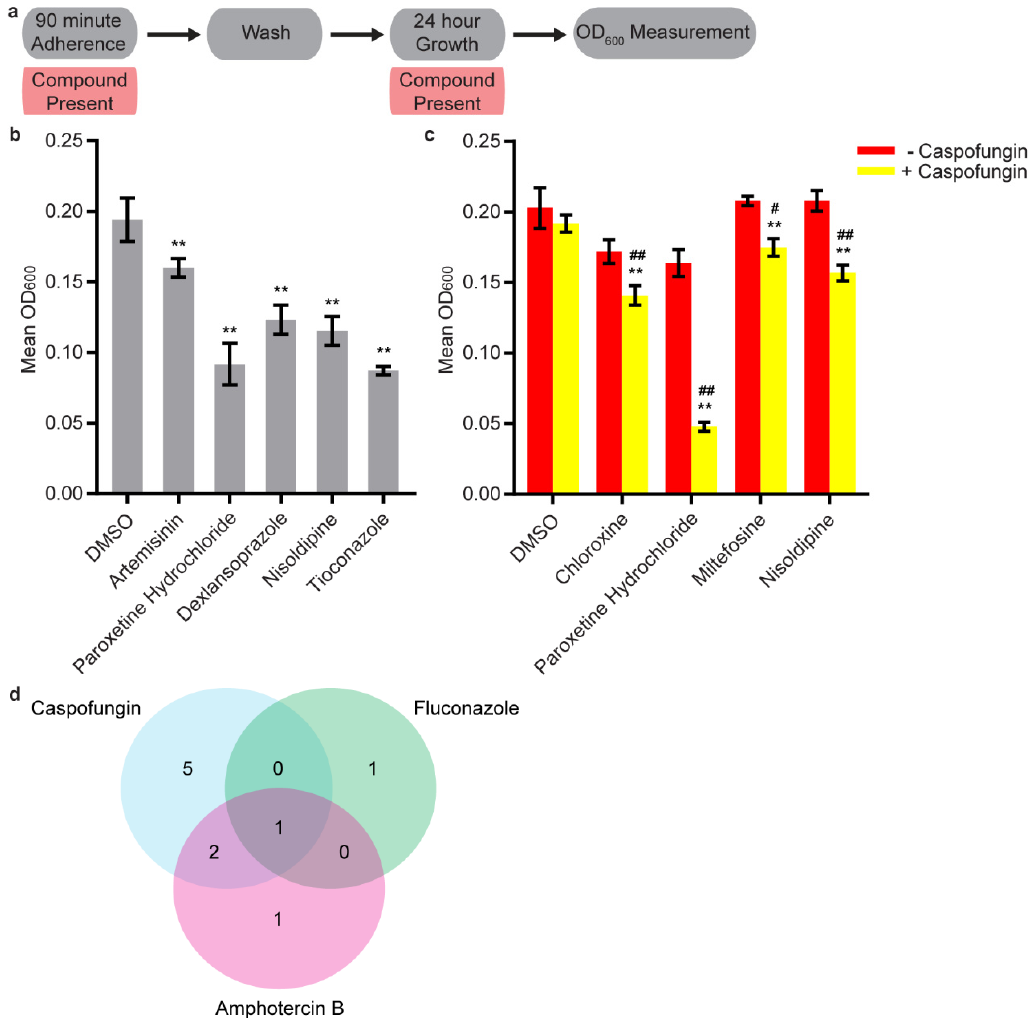
Figure 2. Thirteen candidate compounds inhibited biofilm formation by themselves or in combination with one or more known antifungal agents. ( a ) Overview of the experimental setup for the sustained inhibition optical density biofilm assay used for these experiments. Compounds were included during both the 90-min adherence step and the 24-h growth step of in vitro biofilm formation. ( b ) Subset of the statistically significant hits from the stand-alone sustained inhibition optical density biofilm assay. Mean OD 600 readings with standard deviations are shown, significant di ff erences from the DMSO solvent control as determined by Welch’s t -test (two-tailed, assuming unequal variance) with the Bonferroni correction are indicated for α = 0.05 (*) and α = 0.01 (**). Although a single repeat is shown, the indicated threshold was met by all of the repeats of each compound shown. ( c ) Subset of the statistically significant hits from the combination sustained inhibition optical density biofilm assays with caspofungin. For each compound, the wells with caspofungin ( + caspofungin) are indicated in yellow and wells without caspofungin (– caspofungin) are indicated in red. Mean OD 600 readings with standard deviations are shown; significant di ff erences from the compound without caspofungin control (e.g., chloroxine, − caspofungin), as determined by Welch’s t -test (two-tailed, assuming unequal variance) with the Bonferroni correction, are indicated for α = 0.05 (*) and α = 0.01 (**). Significant di ff erences from the caspofungin without compound control (e.g., DMSO, + caspofungin), as determined by Welch’s t -test (two-tailed, assuming unequal variance) with the Bonferroni correction, are indicated for α = 0.05 (#) and α = 0.01 (##). In panels b and c, data within a chart are taken from the same plate on the same day. ( d ) Venn diagram illustrating the degree of overlap between the combination sustained inhibition screens with amphotericin B, caspofungin, and fluconazole.